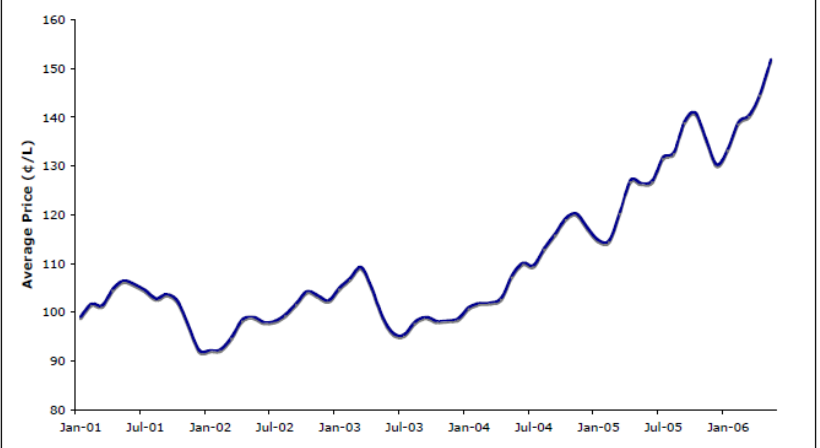
Figure 5. Price of diesel in the mid-west region, western Australia [12].